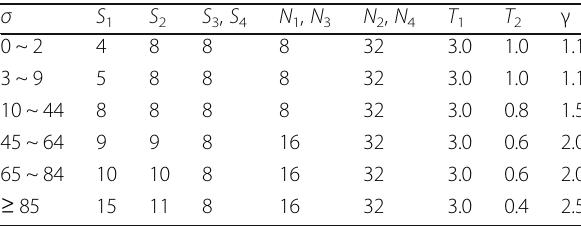
Table 1 Parameter values used in SA-BM1-3D σ